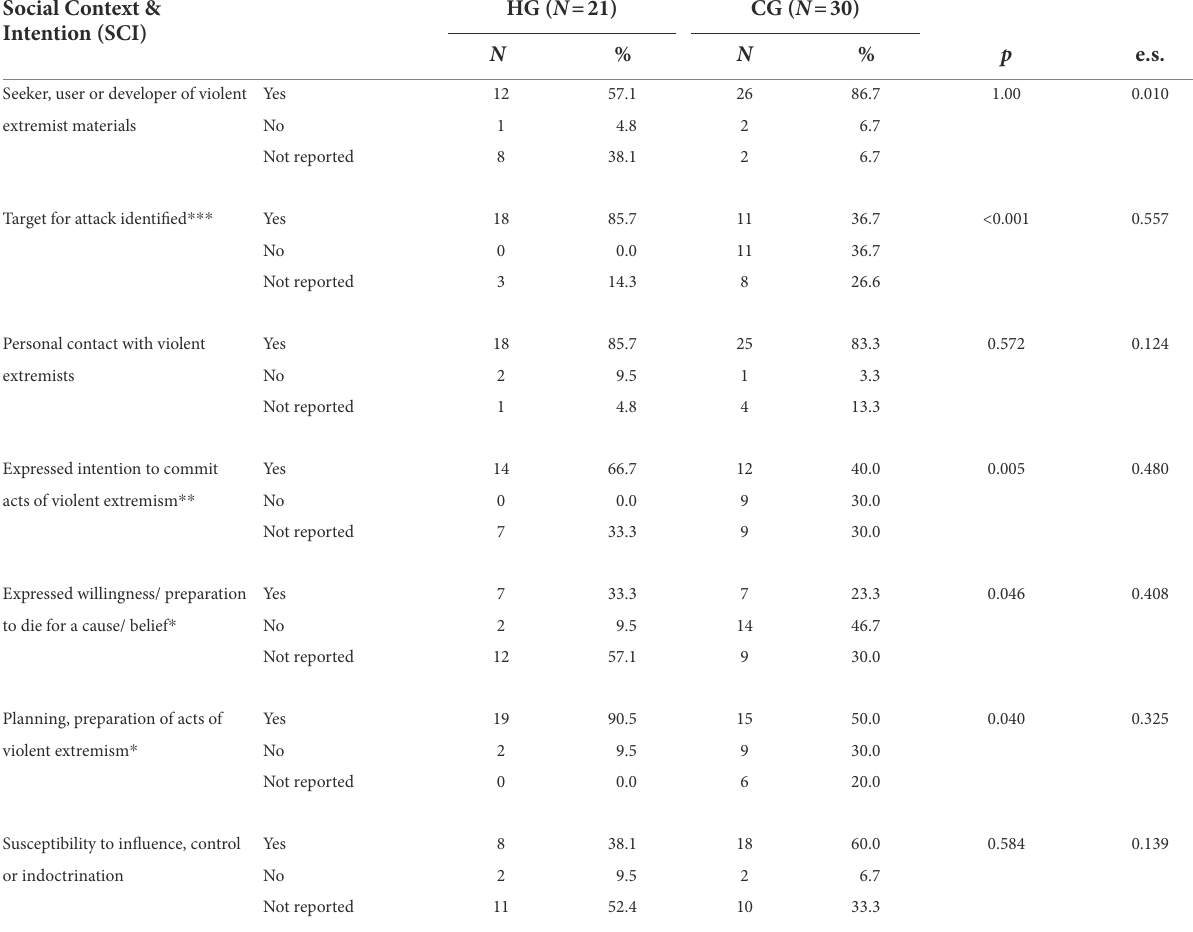
TABLE 4 Social context and intention in male Jihadist homicide offenders (HG) and male Jihadist non-homicide offenders (CG). Social Context & Intention (SCI)